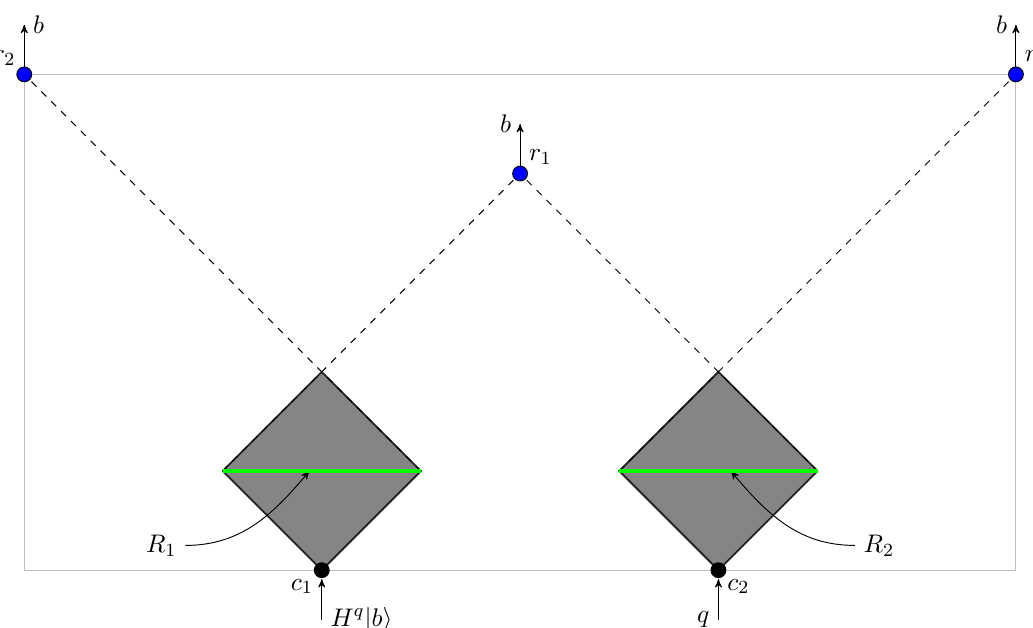
Figure 7. The ^B (cid:2) 1 task. The task takes place in R (cid:2) S 1 , with the right and left vertical grey 84 lines identi(cid:12)ed to form the S 1 . At c 1 Alice receives the state H q j b i with b 2 f 0 ; 1 g and at c 2 she receives the classical bit q . At r 1 and r 2 Alice is required to return b . The grey diamonds are the input regions, de(cid:12)ned by D ( R i ) = J + ( c i ) \ J (cid:0) ( r 1 ) \ J (cid:0) ( r 2